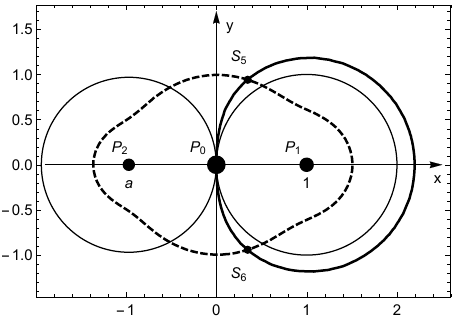
Figure 4. Triangular equilibrium positions S 5 and S 6 , µ 1 = 0 . 1, µ 2 = 0 . 04, a <